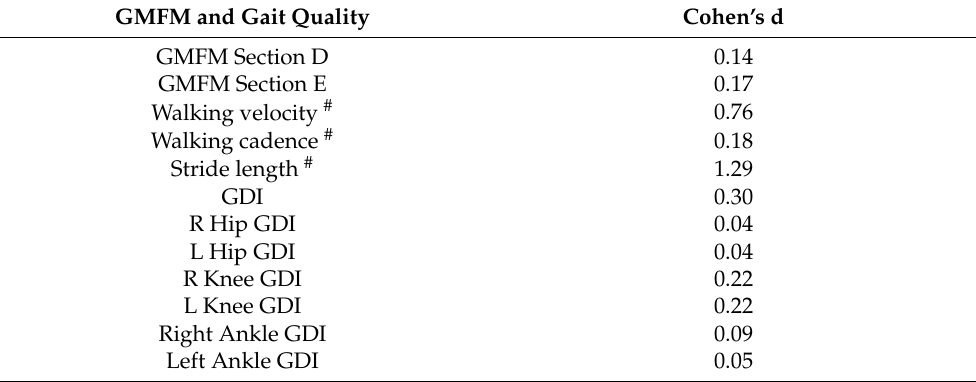
Table 6. Effect sizes (Cohen’s d) of GMFM scores and gait